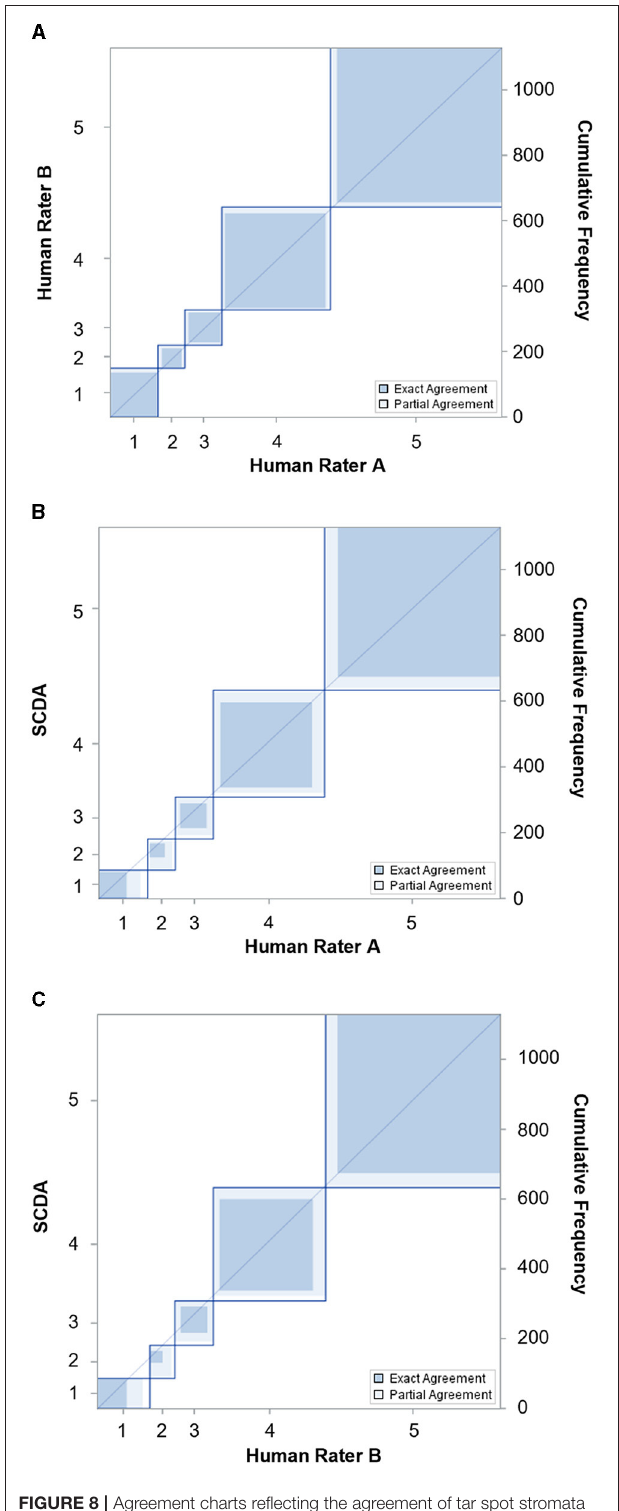
FIGURE 8 | Agreement charts reflecting the agreement of tar spot stromata counts (classes 1 to 5) between (A) two human raters, (B) human rater A and SCDA, and (C) human rater B and SCDA after kappa